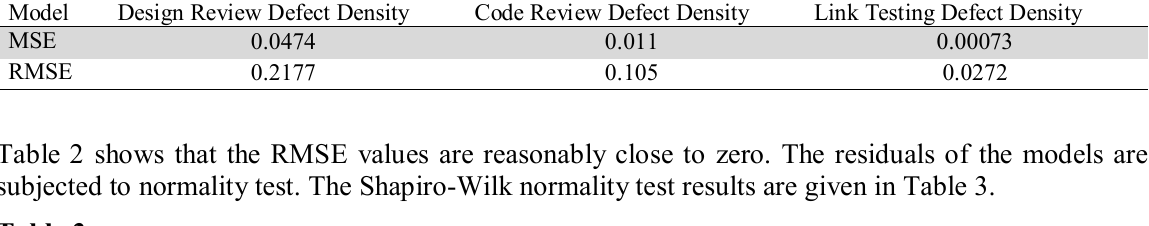
MSE and RMSE values of the models Model